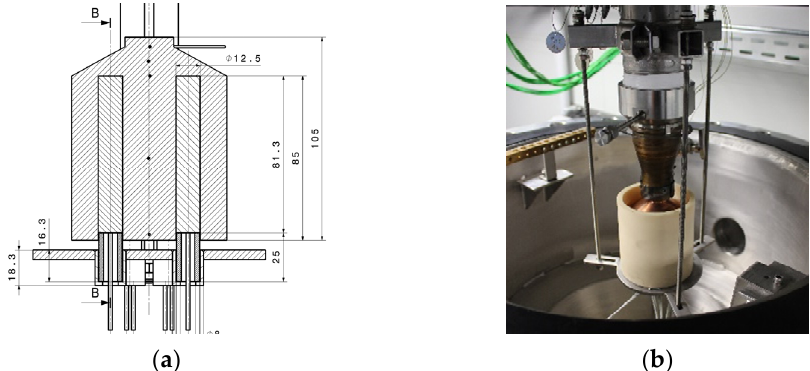
Figure 9 . Structure of electric copper heater: ( a ) assembly illustration; ( b ) installation with ceramic isolation.